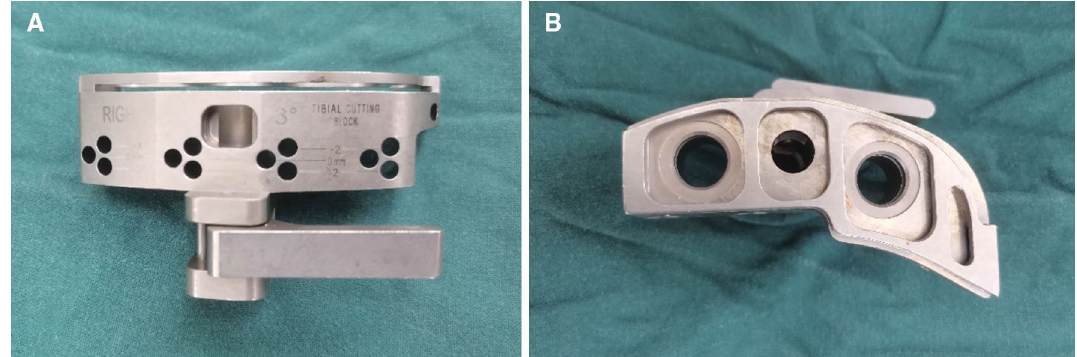
Figure 1. (A,B ) Tibial cutting block provided by Smith & Nephew has an angle of posterior inclination of 3° for the Legion system.